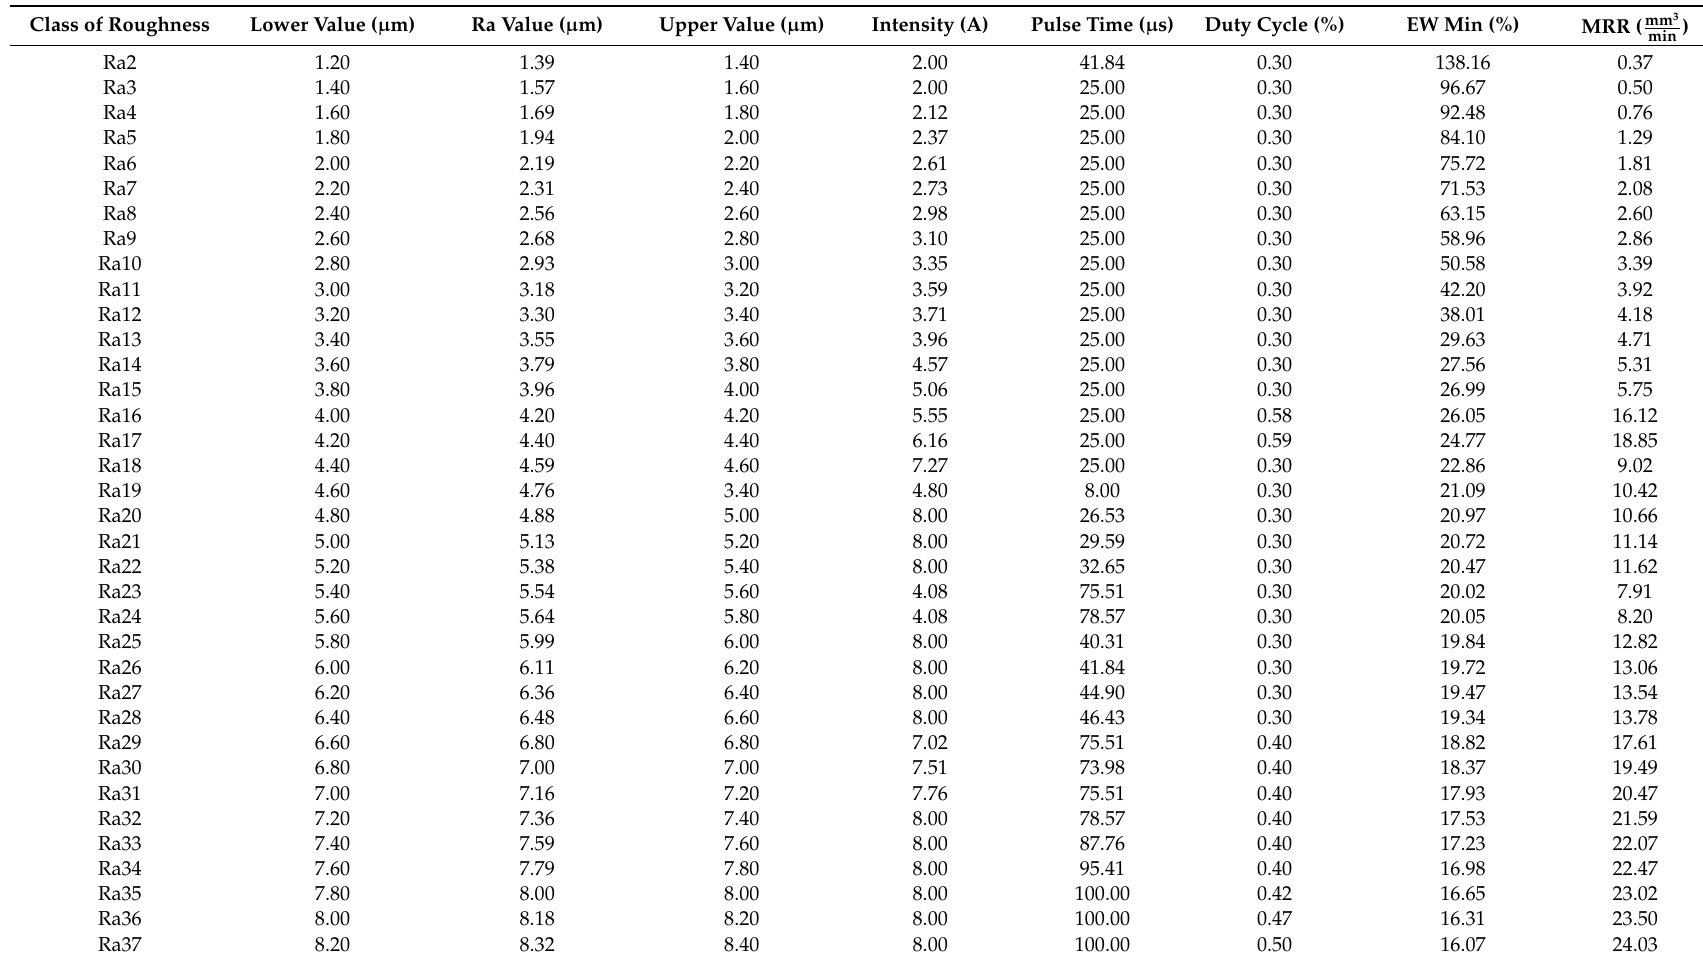
Table 8. Strategy of minimum electrode wear. Technological table obtained from the FIS, for the case of minimum electrode wear strategy (negative polarity). Class of